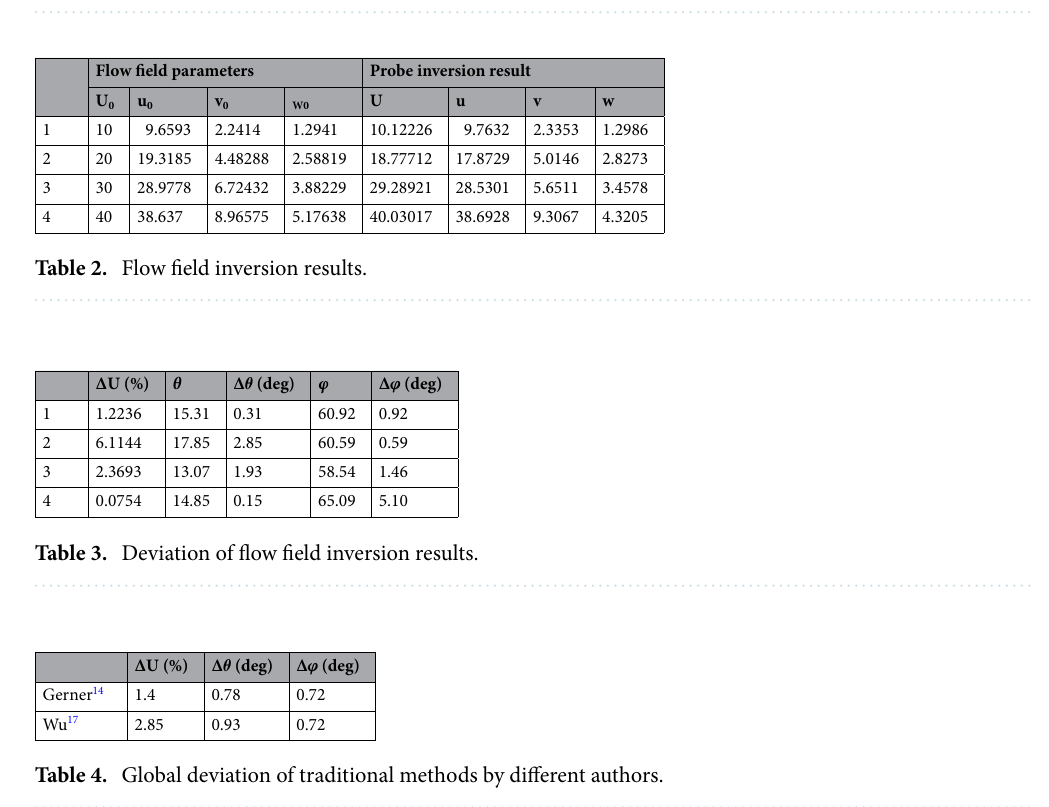
Figure 9. ( a ) Variation curve of pitch pressure coefficient with angle of attack. ( b ) Variation curve of yaw pressure coefficient with angle of attack.